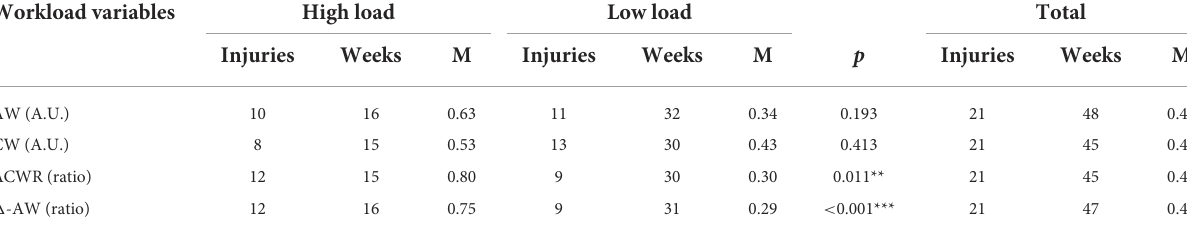
TABLE 2 The relation between AW, CW, ACWR, and 1 -AW with non-contact injuries. Workload